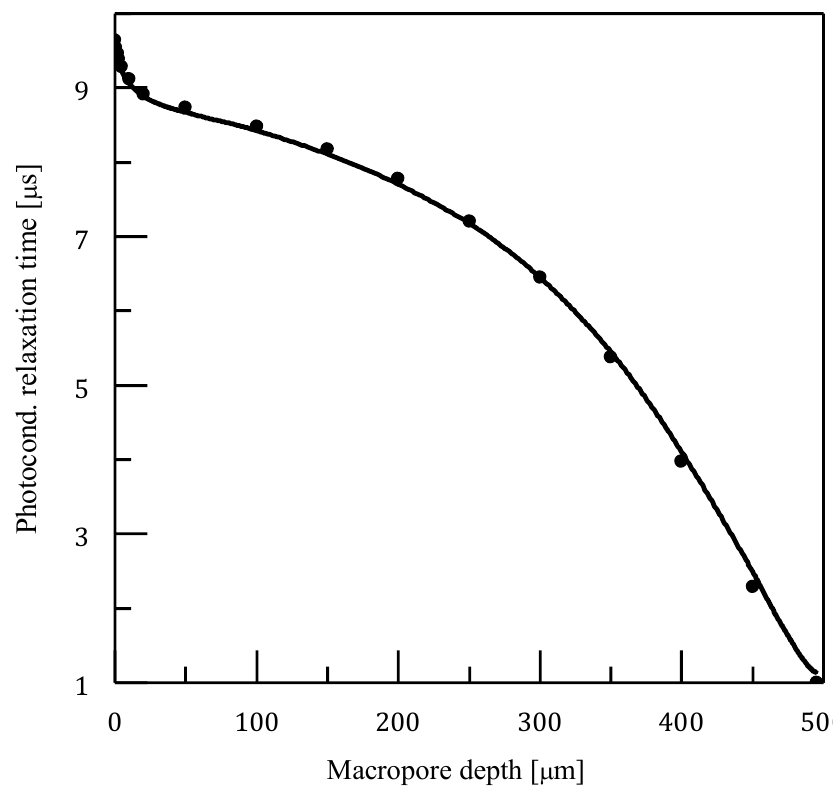
Figure 3. The dependence of photoconductivity relaxation time in macroporous silicon on the depth of the macropores is shown as a solid line. Circles show numerical calculations of photoconductivity relaxation time [12]. 3-2- The Calculation of Photoconductivity Relaxation Time Depending on the Depth of Macropores, the